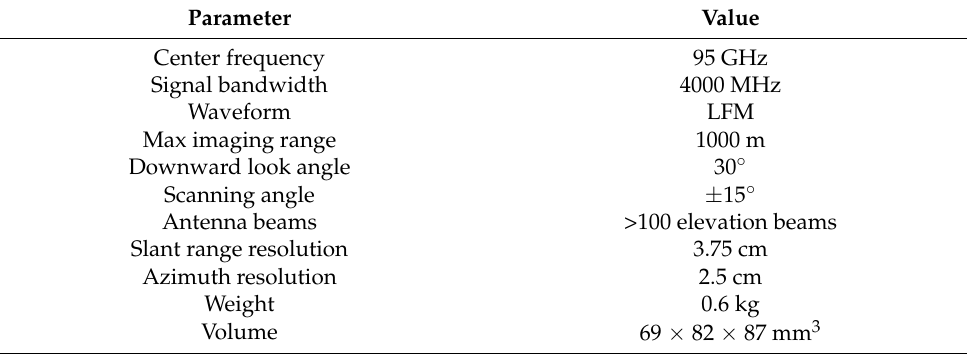
Table 1. Key parameters of the W-Band APA